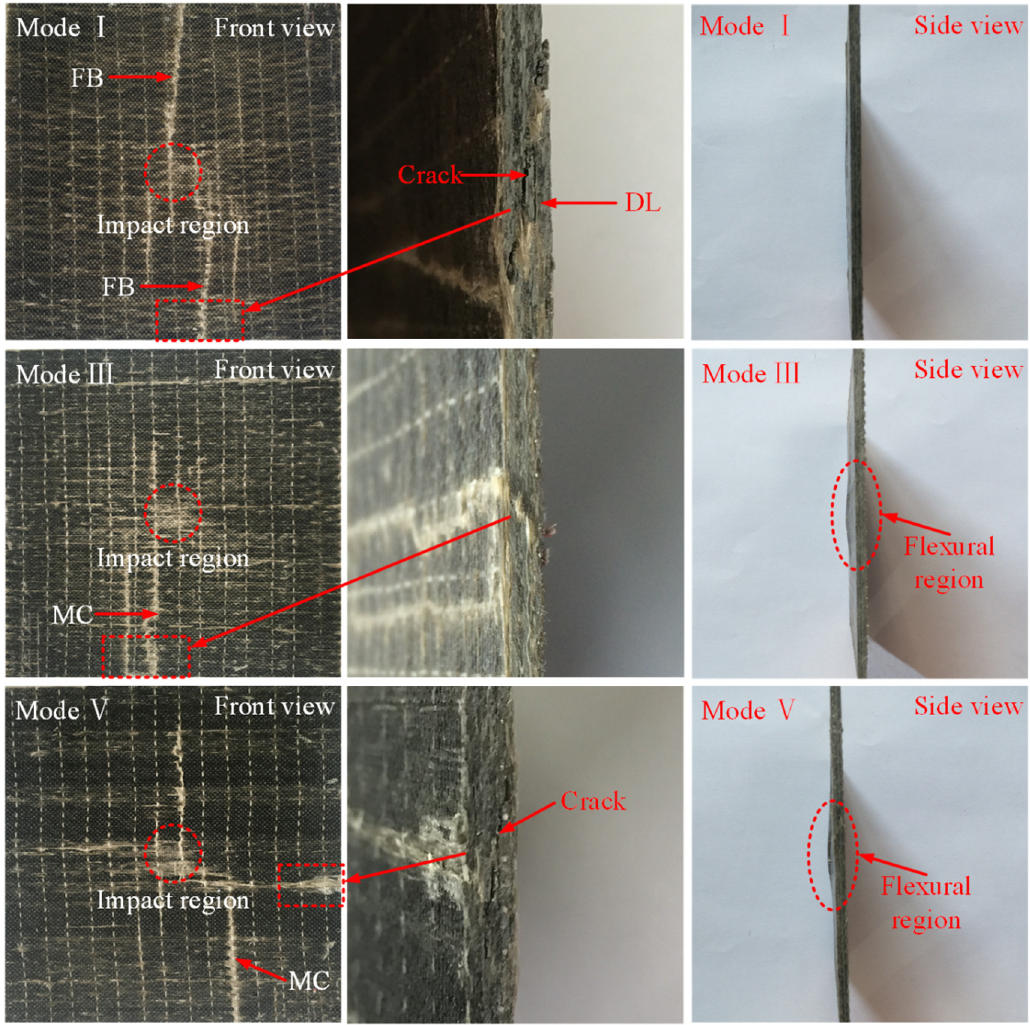
Figure 6. Typical damage modes of the samples with 60 J impact. Notes: in the figure, MC indicates the matrix cracking, FB represents the fiber breakage and DL illustrates the delamination.